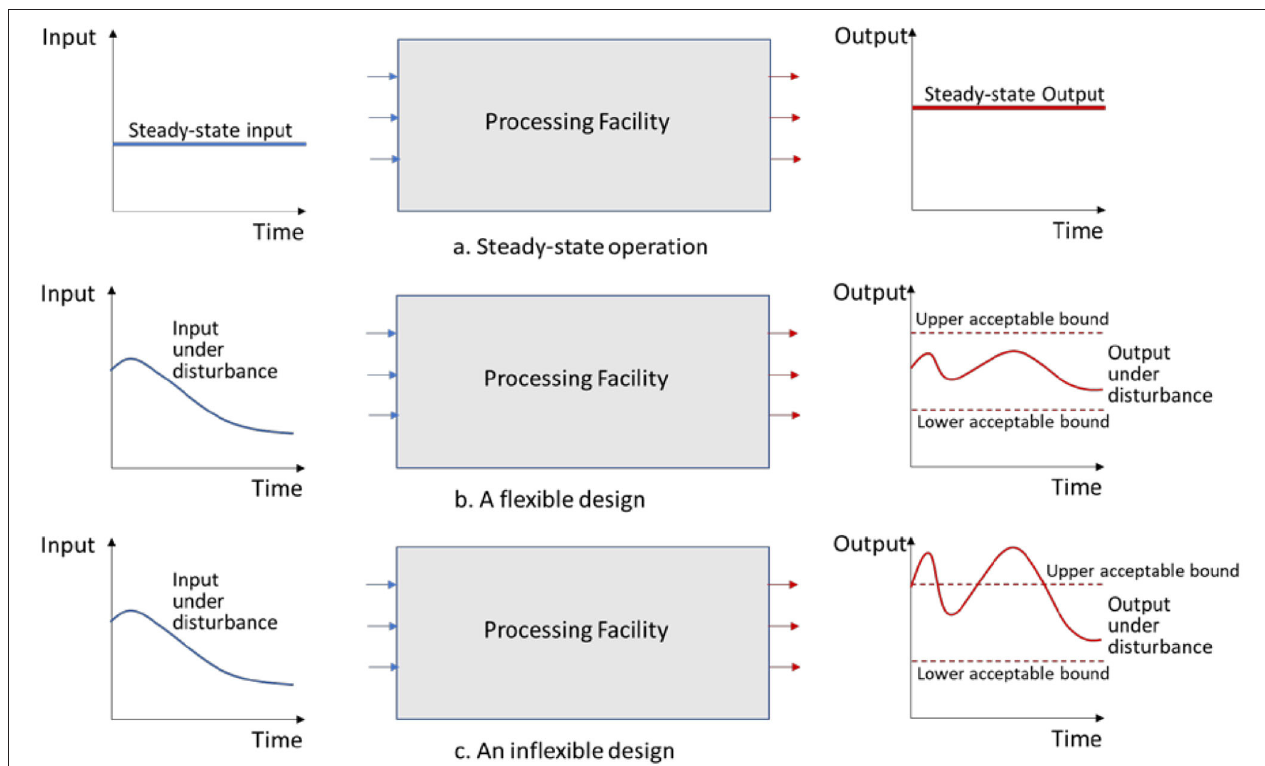
FIGURE 8 | Flexibility assessment: (A) Under steady-state conditions, (B) A flexible design, and (C) an Inflexible design.